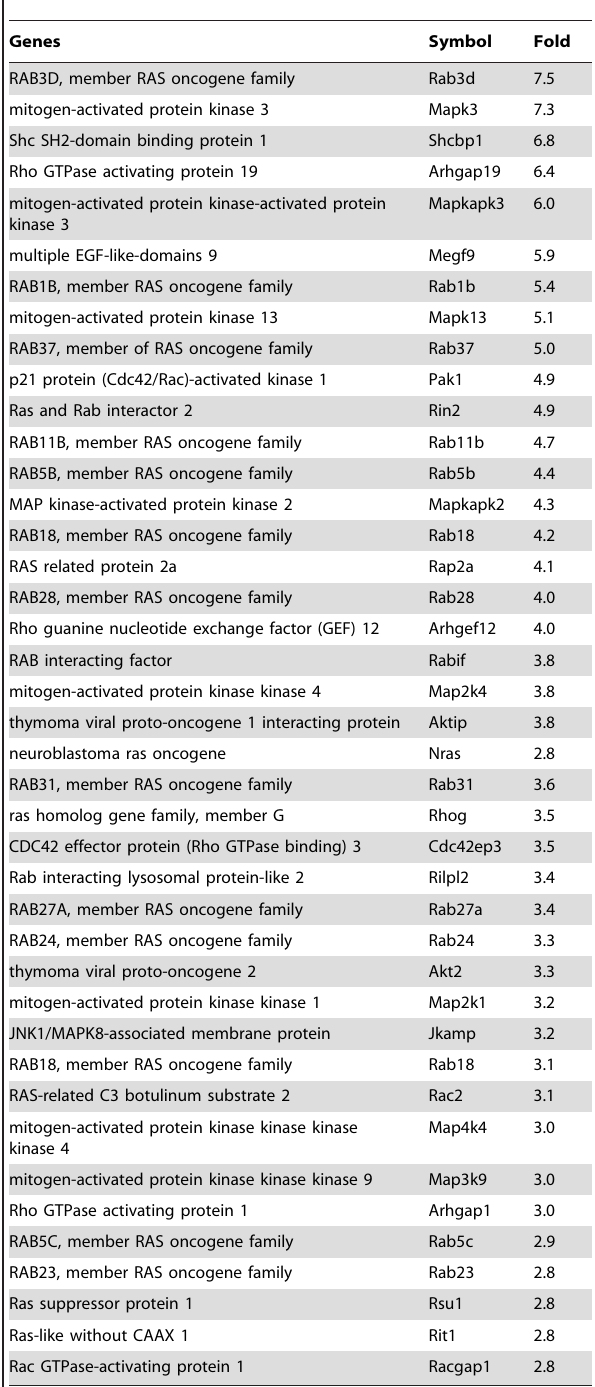
Table 3. Increases of monomeric low-molecular-weight Ras GTPase superfamily in lal 2 / 2 bone marrow MDSCs.